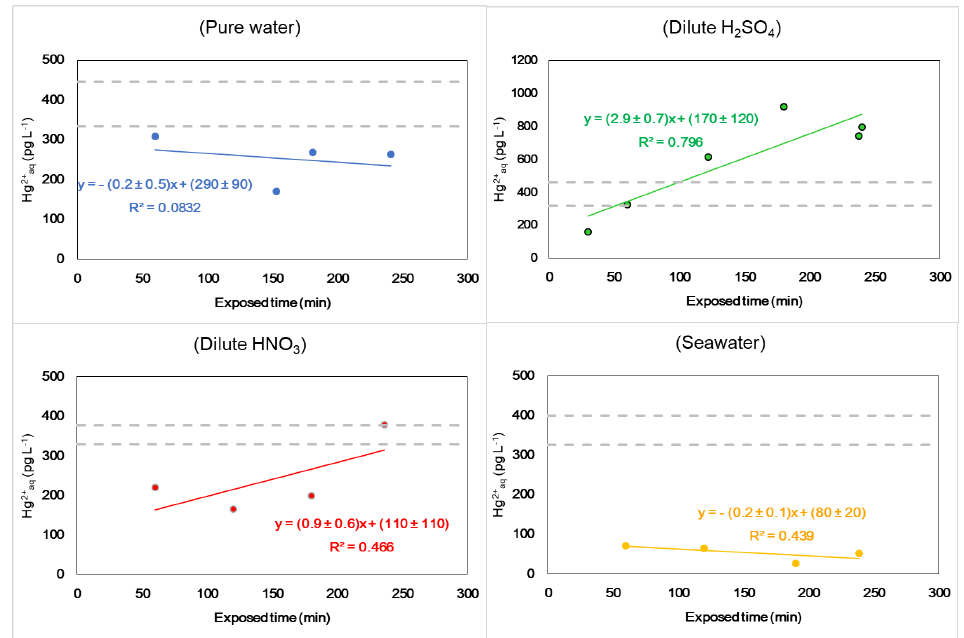
Figure 4. Concentration of dissolved oxidized mercury (Hg 2+ aq ) in a variety of uptake solutions as a function of the exposure time to the standard gas of 101–153 ng m − 3 gaseous elemental mercury. The gray horizontal lines shown in each plot are for the lowest and highest equilibrated concentrations of Hg 0 aq , according to Henry’s law, estimated through the use of the temperature and GEM concentrations provided in Table 2 and Henry’s constants in the literature [7] The linear regressions are also shown in the f igures, and the uncertainties shown for each regression are standard errors. The lowest Hg 2+ aq concentration data point in the seawater plot is below the detection limit.